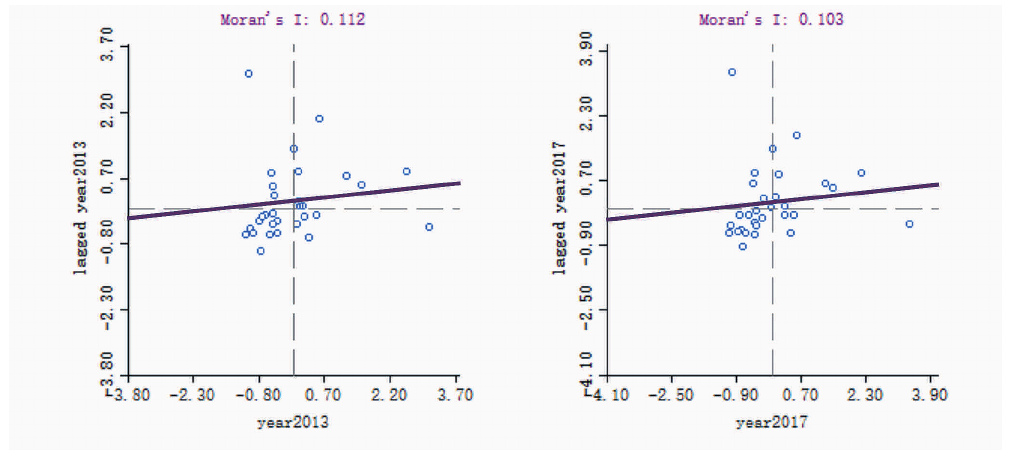
Figure 7. Moran’s I index scatter charts of the RLGIL in 2013 and